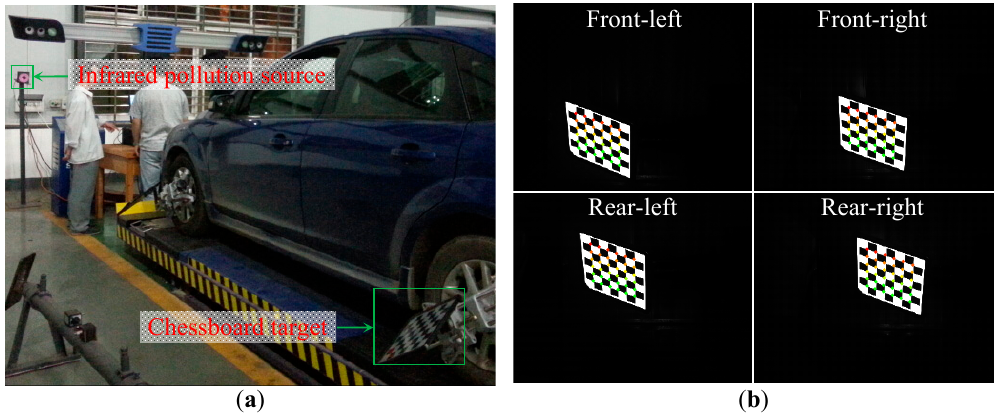
Figure 17. On-site aligning experiment. ( a ) Using infrared light as pollution source. ( b ) One shot in image sequence with located corners for each wheel position.